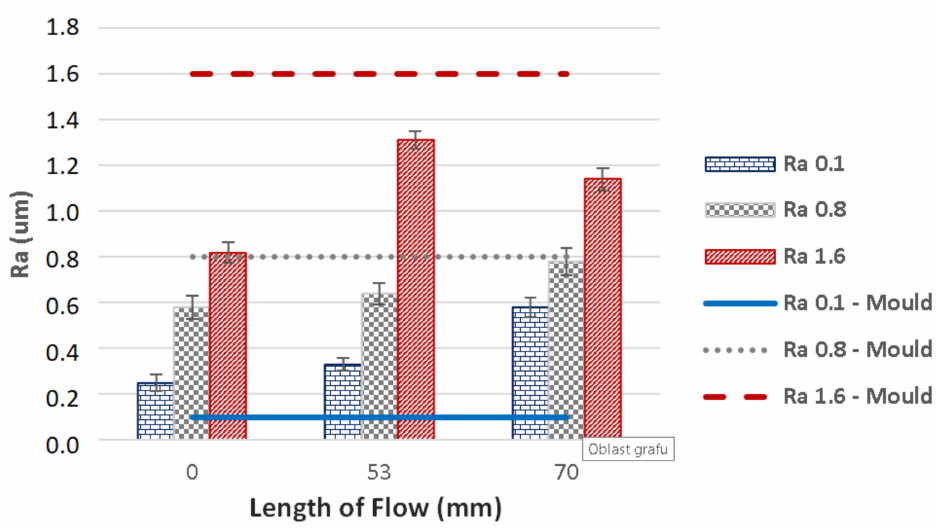
Figure 12. Dependence of the flow length on the surface quality of the mould and the product— injection pressure 800